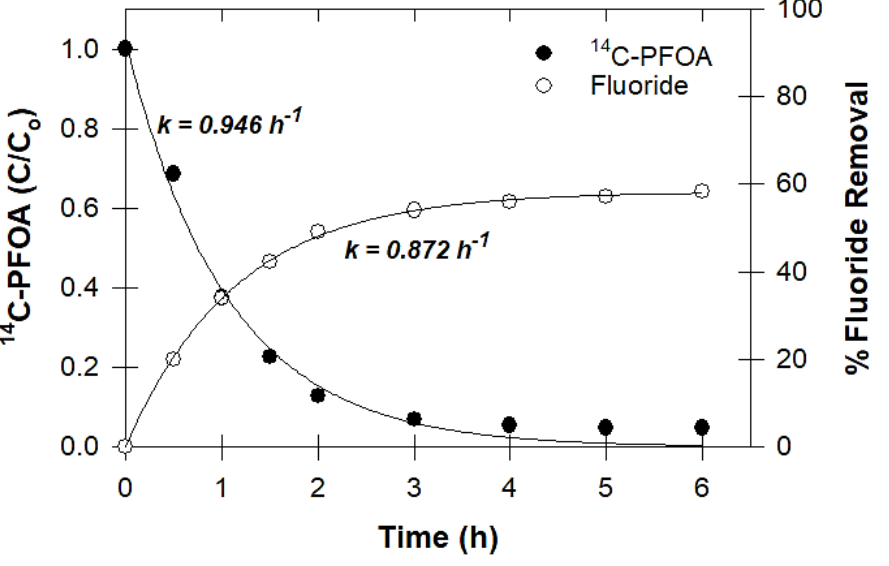
Figure 6. Temporal changes in 14 C-PFOA and fluoride concentrations. Experimental conditions: BDD anode and cathode; 100 mg L −1 PFOA, acidified, 20 V, 1 A.